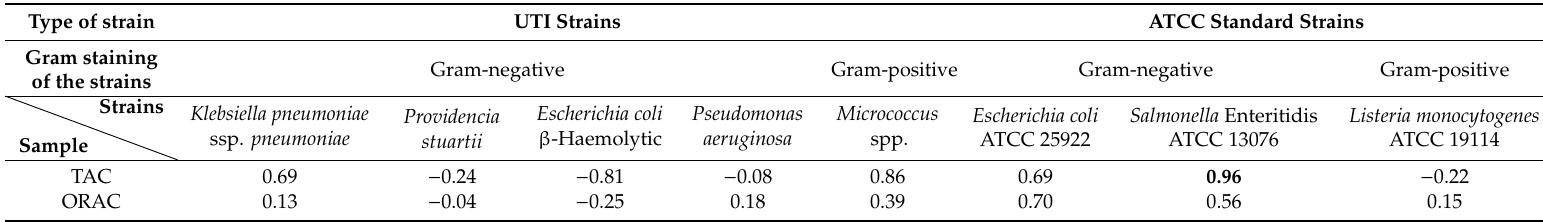
Table 6. Pearson correlation matrix of the minimum inhibitory concentration (MIC) and minimum bactericidal concentration (MBC), with the total anthocyanin content (TAC) of the four varieties of blueberries and the antioxidant capacity, as assessed by the ORAC.